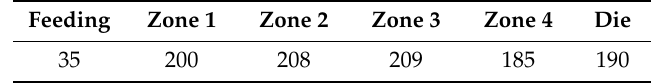
Table 1. Temperatures in ◦ C for the di ff erent zones in the extruder for the preparation of films.